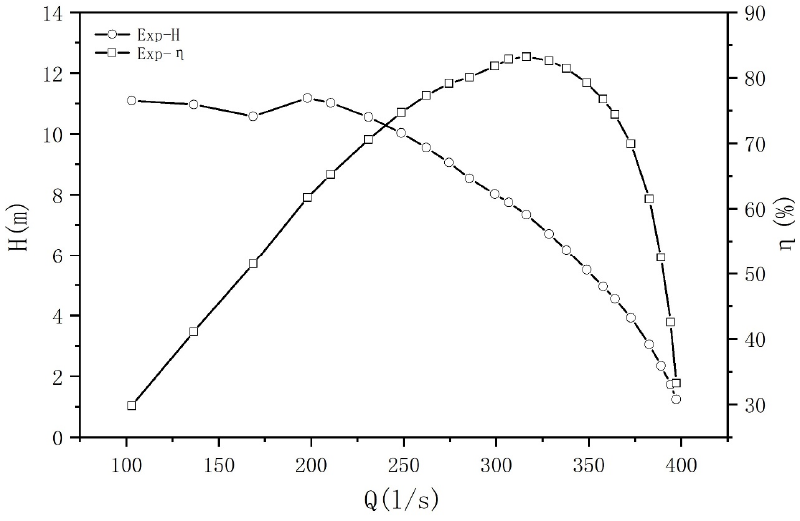
Figure 7. Comparison of η – σ between digital model and experiment.